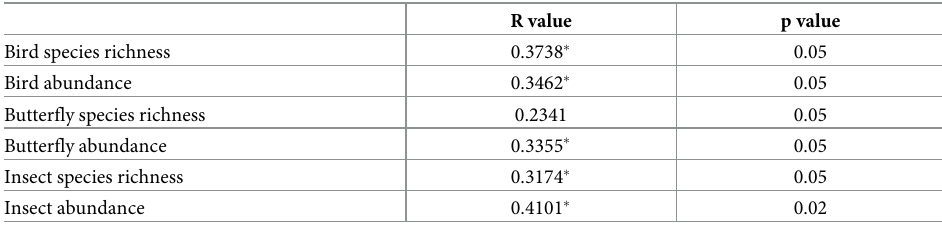
Table 2. Regression analysis of habitat complexity values across all three taxa within NPs.